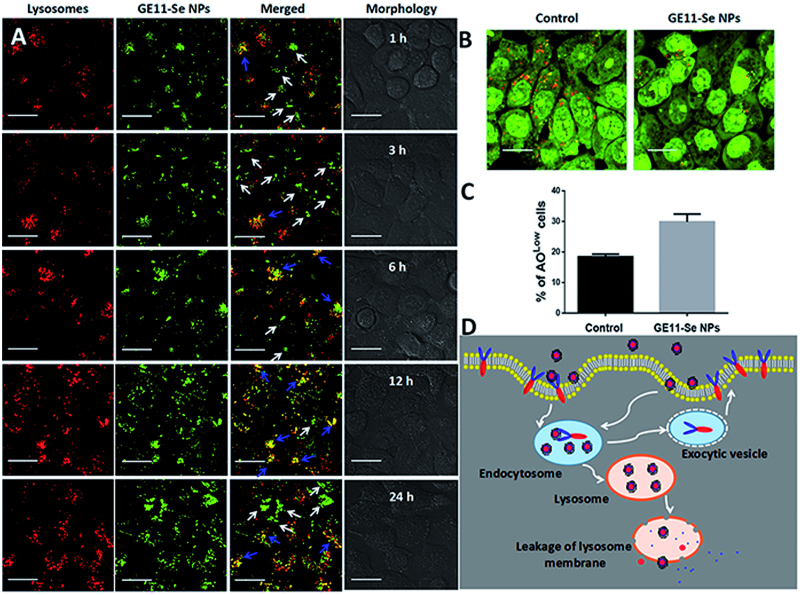
Intracellular localization of GE11-Se NPs. (A) Intracellular trafficking of coumarin-6-loaded GE11-Se NPs. KYSE-150 cells treated with coumarin-6-loaded GE11-Se-NPs (80 μM) were stained with lysotracker (lysosome) or different periods of time and visualized under a confocal microscopy, scale bar: 20 μm. The changes in integrity of the lysosomal membrane (AO staining) in KYSE-150 cells after 24 h GE11-Se-NPs (80 μM) by (B) confocal microscopy and (C) flow cytometry, scale bar; 30 μm. (D) Proposed endocytosis pathway of GE11-Se-NPs in KYSE-150 cells.